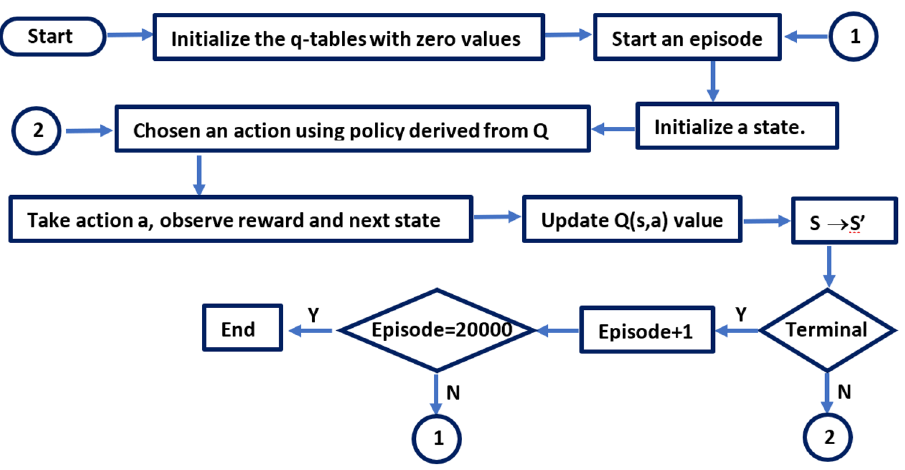
Figure 4. Diagram of Q-learning in the proposed